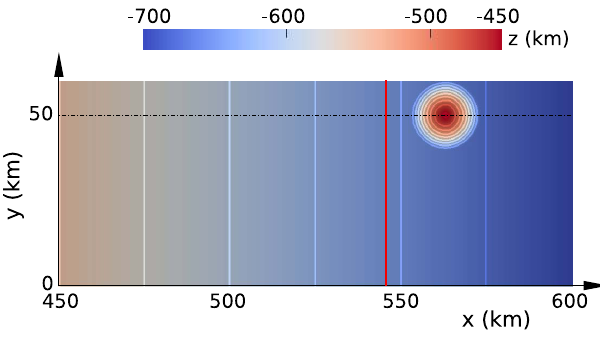
Fig. 4. Top view of the bedrock geometry (zoom around the initial grounding line and the bump, the 60 km width shown does not rep- resent the full domain), consisting of a linearly inclined area and a Gaussian bump. Altitude isovalues are displayed every 25 m. The symmetry plane at y = 50 km is shown by the dashed